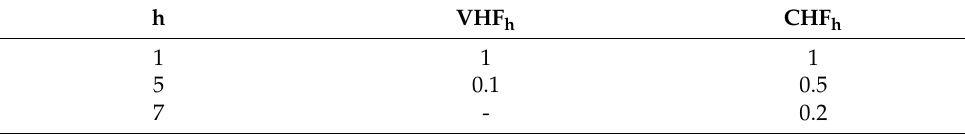
Table 2. Factors used to express harmonics of voltage and